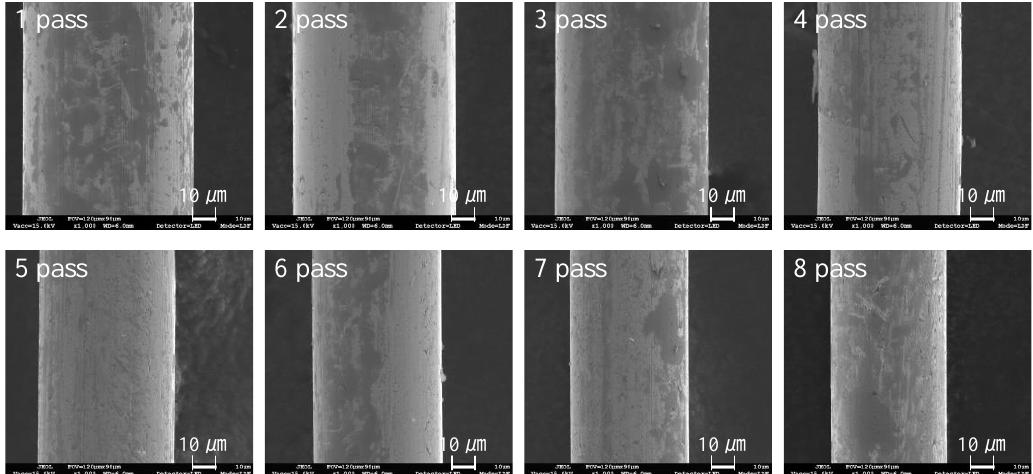
Figure 14. SEM image ( × 1000 ) of the drawn wire at each pass.